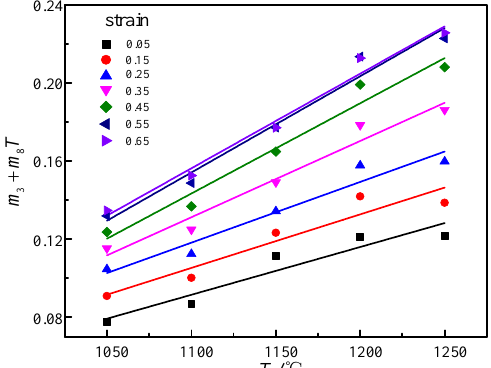
Figure 5. Relationships between m 3 + m 8 T and T under different strains. When the strain rate and strain are constant, ln A + m 2 ln ε + m 3 ln to K 2 is set to get the following formula (7):